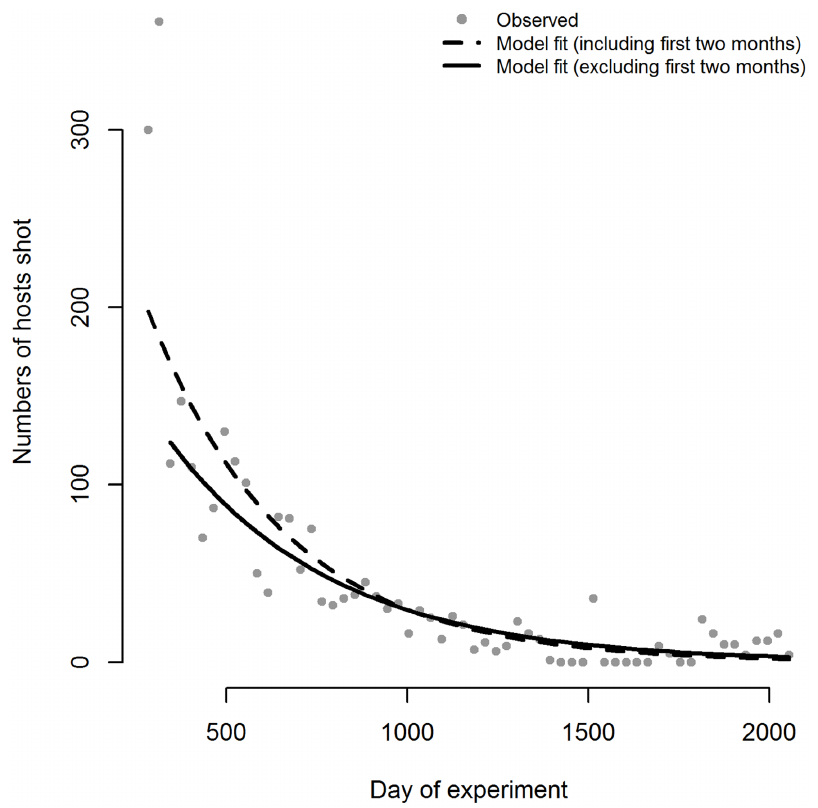
Fig 2. Numbers of hosts shot during the Nagupande experiment. The numbers shot each month are modelled using Eq 1 –either modelling all data together with a constant kill rate throughout(dashedline), or assuming that the kill rate was higherduringthe first two months of the study (solid line). Assuminga growth rate ( r ) of 0.007 month -1 the model fitted to data for all months gave estimates of k 1 = 2591(2492–2693), k 2